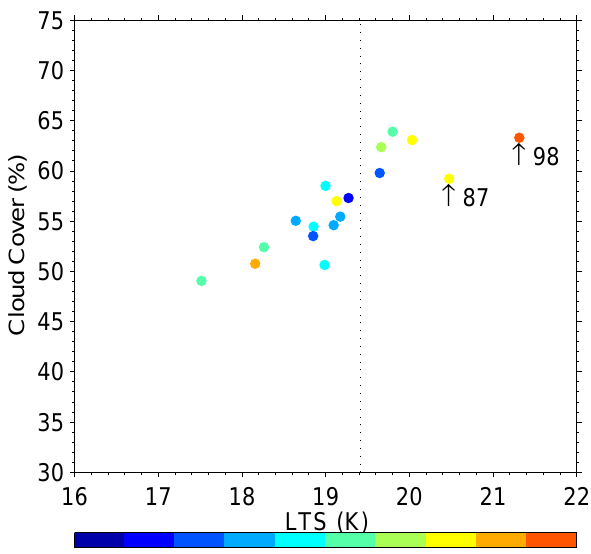
Fig. 12. Scatterplot of the area-averaged (70 ◦ –110 ◦ W, 10 ◦ –30 ◦ S) LTS versus adjusted low cloud amount for DJF season from 1983 to 2002, colored by the DJF mean ni˜no3.4 index, an indicator of ENSO defined as area-averaged (170 ◦ W–120 ◦ W, 5 ◦ S–5 ◦ N) SST in the tropical